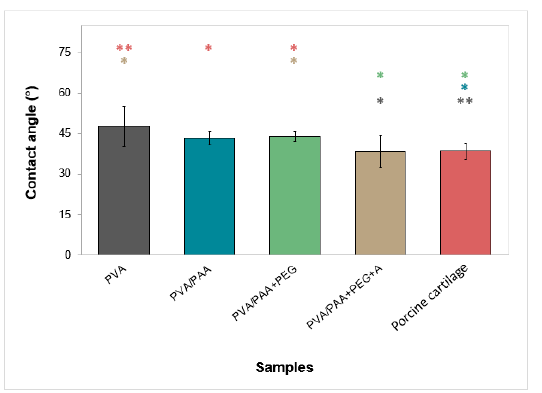
Figure 3. Water contact angles with hydrogels. Error bars are the ± standard deviations, n = 8. Data were tested using Welch’s ANOVA ( p > 0.05). Statistical differences are indicated by asterisks (* p < 0.05, ** p < 0.005).